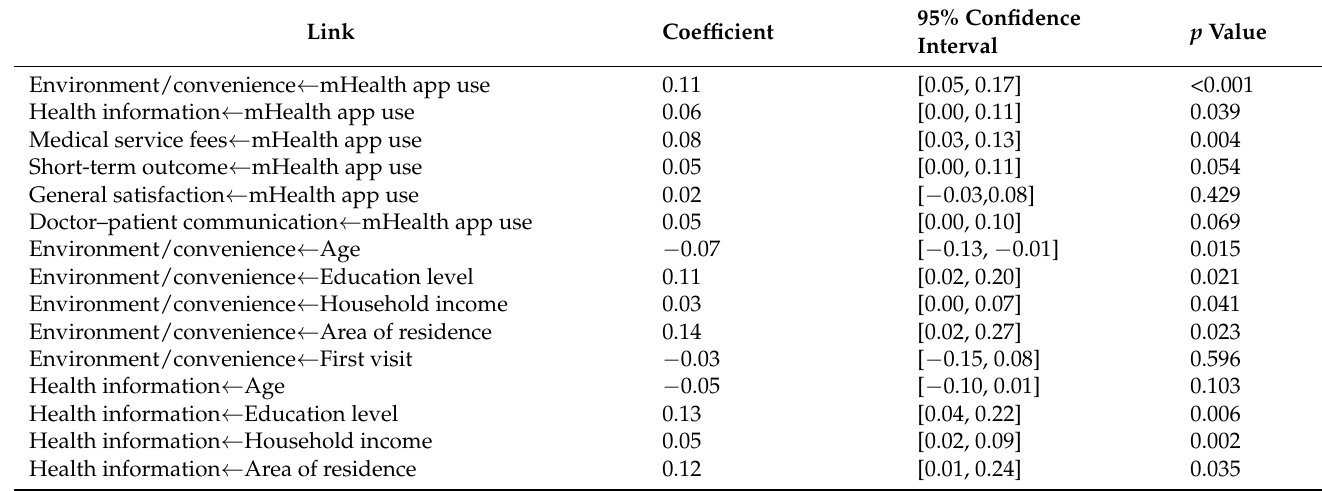
Table 5. Regression weights of parameters by multiple indicators, multiple causes model with structural equation